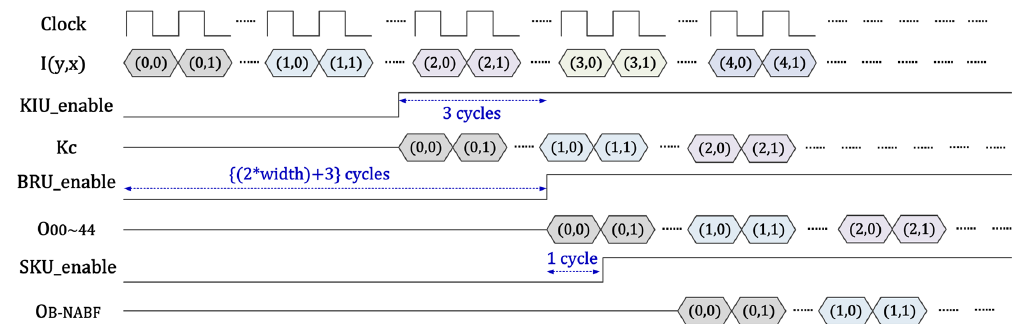
Figure 4. Control and timing diagram for pipelined operation. Here, I denotes the pixel intensity of an input image; x and y denote horizontal and vertical position in an image, respectively; KIU, BRU, and SKU are K C interpolation unit, binary range kernel unit, and spatial kernel unit, respectively; K C , O 00 ∼ O 44 , and O B − NABF are outputs of KIU, BRU, and SKU,